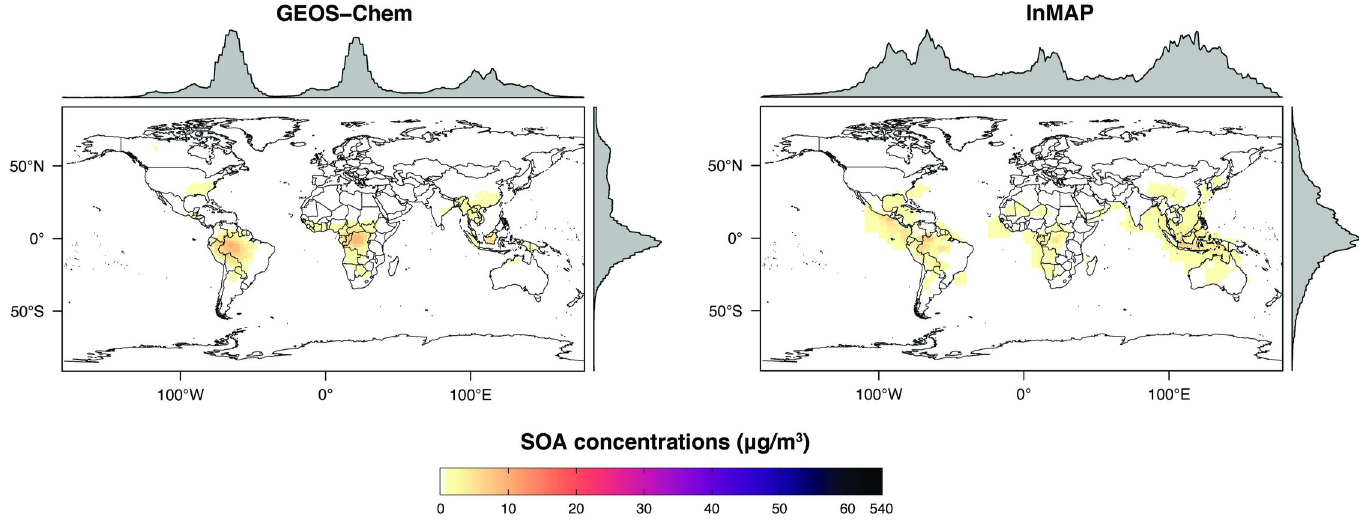
Fig 9. Global InMAP and GEOS-Chem annual-average ground-level SOA concentrations.